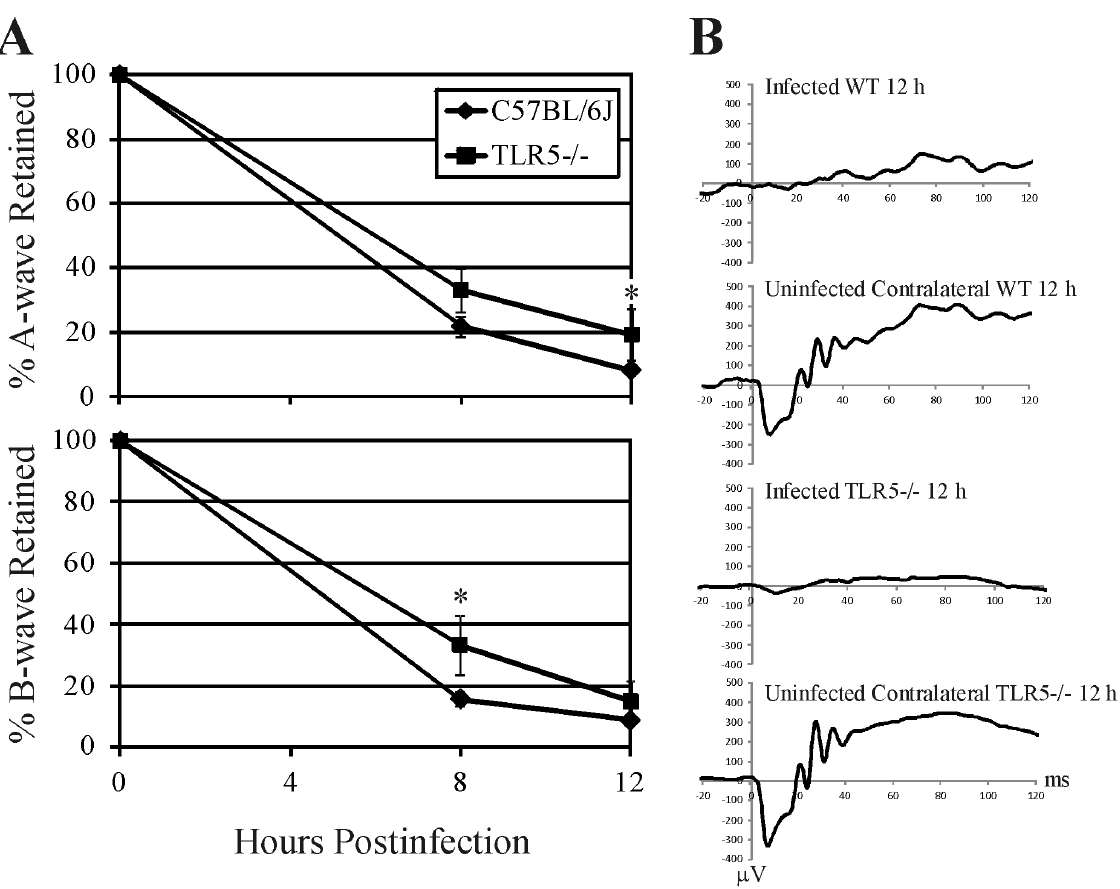
Figure 2. Influence of TLR5 on retinal function during experimental B.cereus endophthalmitis. C57BL/6J wild type and TLR5 2 / 2 mouse eyes were injected with 100 CFU B. cereus . Retinal function was assessed by electroretinography (ERG). A ) A-wave amplitudes were slightly greater in C57BL/6J infected eyes at 12 h postinfection (P=0.02), while B-wave amplitudes were greater in TLR5 2 / 2 infected eyes at 8 h postinfection (P=0.008). By 12 hours postinfection, A-wave and B-wave amplitudes retained in both groups decreased to approximately 20% or less in infected eyes, indicating significant retinal function loss in both groups of mice regardless of the presence of TLR5. Values represent the mean 6 SD of N $ 4 eyes per time point for at least 2 separate experiments. *P # 0.05. B ) Representative averaged waveforms from wild type (WT) and TLR5 2 / 2 mice at 12 h postinfection, with one eye infected and the contralateral eye serving as the uninfected control. Representative of N $ 4 eyes per time point.